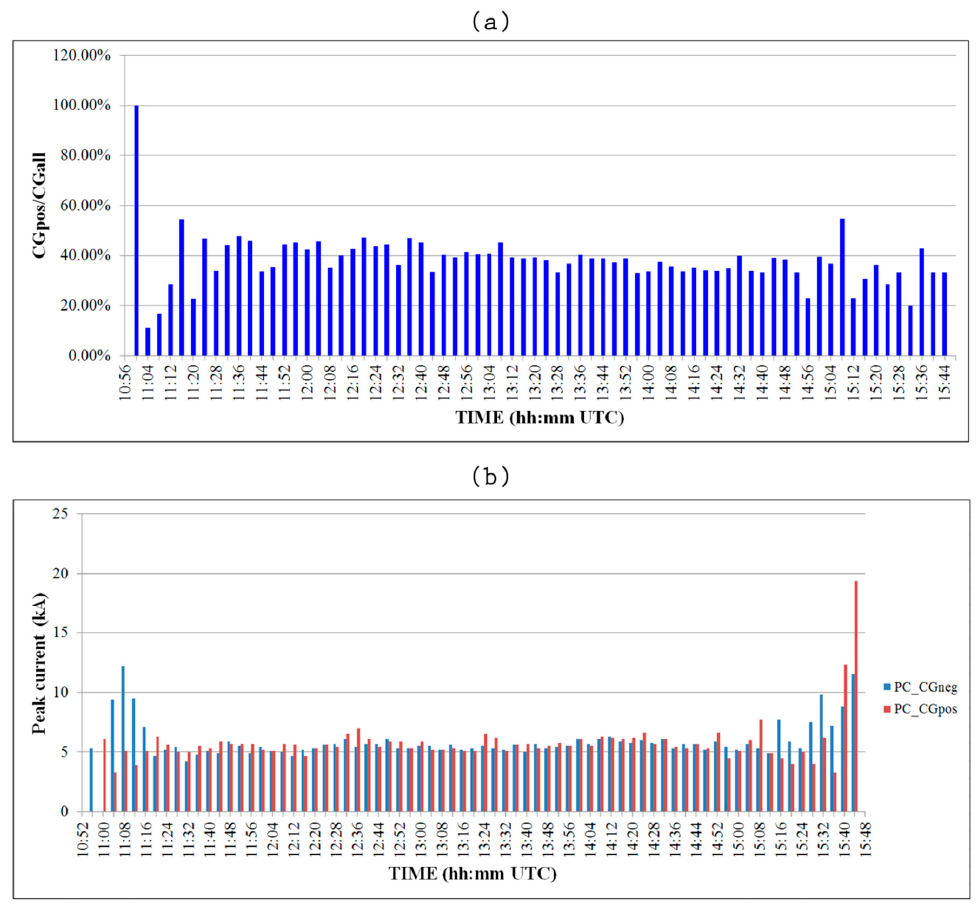
Figure 9. Temporal trends in ( a ) the ratio of positive to all CG lightning strikes (CGpos / CGall) and ( b ) the 4-min averaged peak current associated with negative (PC_CGneg) and positive (PC_CGpos) lightning strikes.